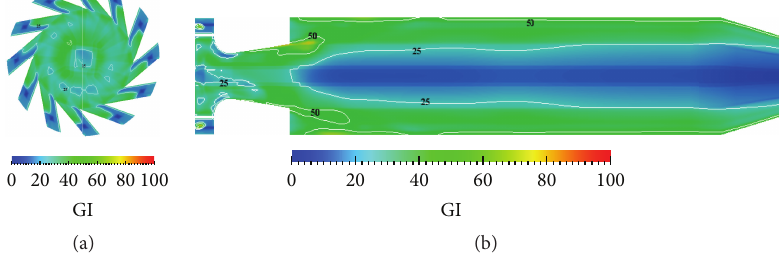
Figure 4: Distribution of GI in planes through (a) swirler and (b) combustor.